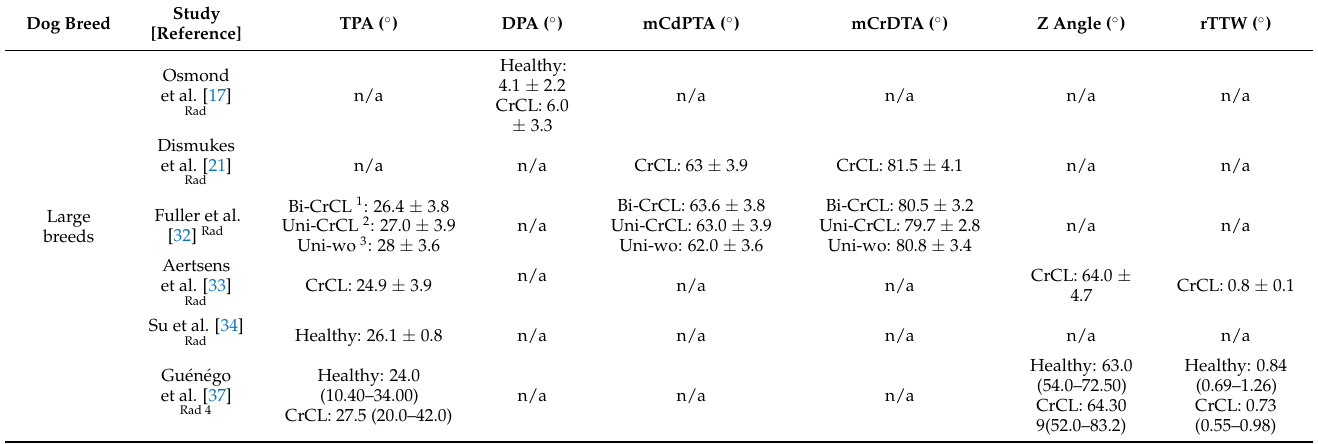
Table 16. Mean ± standard deviation of the tibial alignments in the sagittal